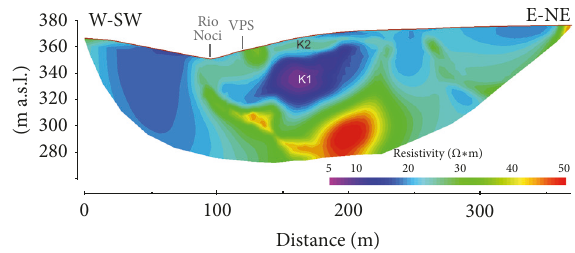
Figure 3: Resistivity profile showing a three-layer structure. The near surface medium resistivity unit is marked with letter K1, while the underlying very conductive body is marked with letter K2. In the deepest layer, resistivity raises up to values larger than 50 Ω∗